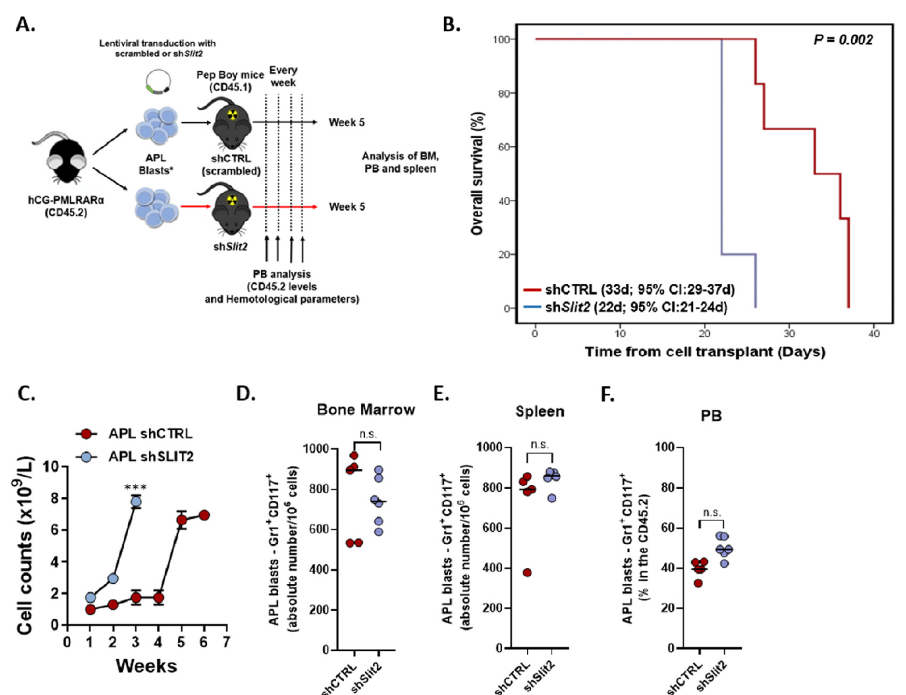
Figure 3. SLIT2 knockdown induces APL clonal expansion and reduces overall survival in vivo.